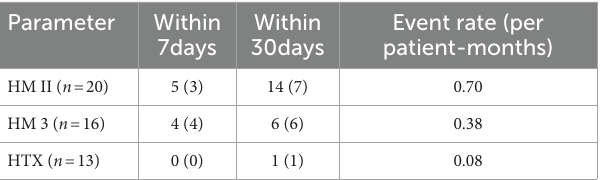
TABLE 3 Number of bleeding complications and number of patients with respective bleeding complications (parenthesized) within seven and 30 days after surgery in HM II, HM 3, and HTX